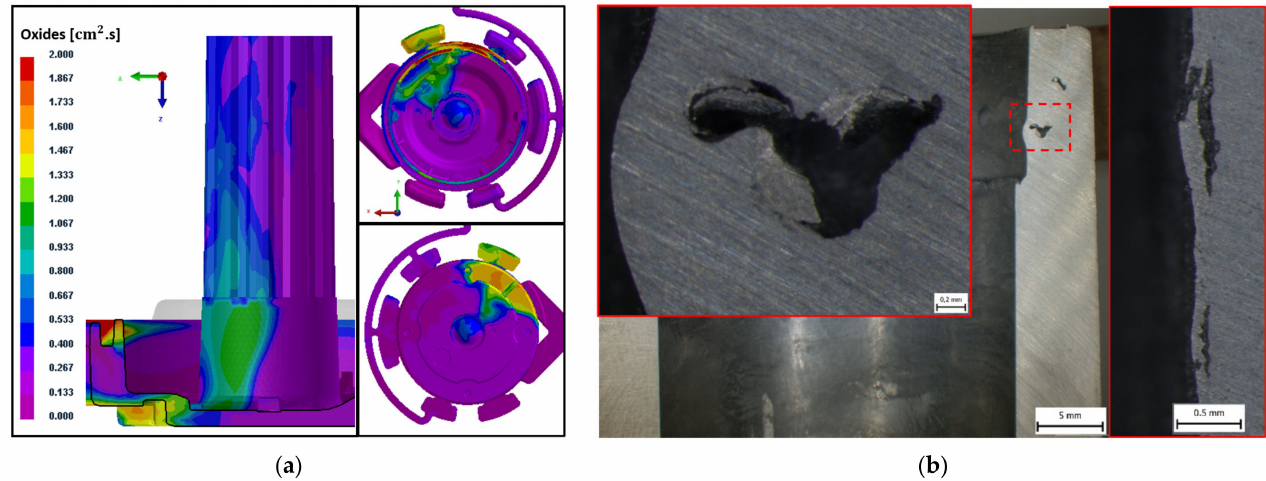
Figure 15. Porosity occurring near the casting walls: ( a ) Numerical simulation showing surface regions with increased presence of oxides; ( b ) Pores disrupting the geometry of the casting from Z55, after heat